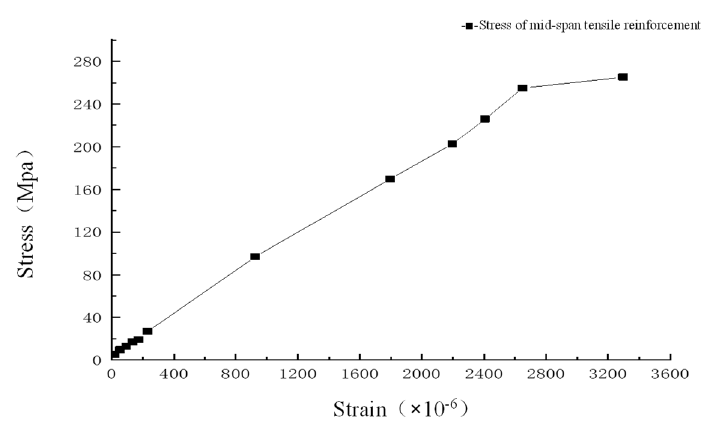
Figure 34. Stress − strain relationship curve of span − stayed steel bars.